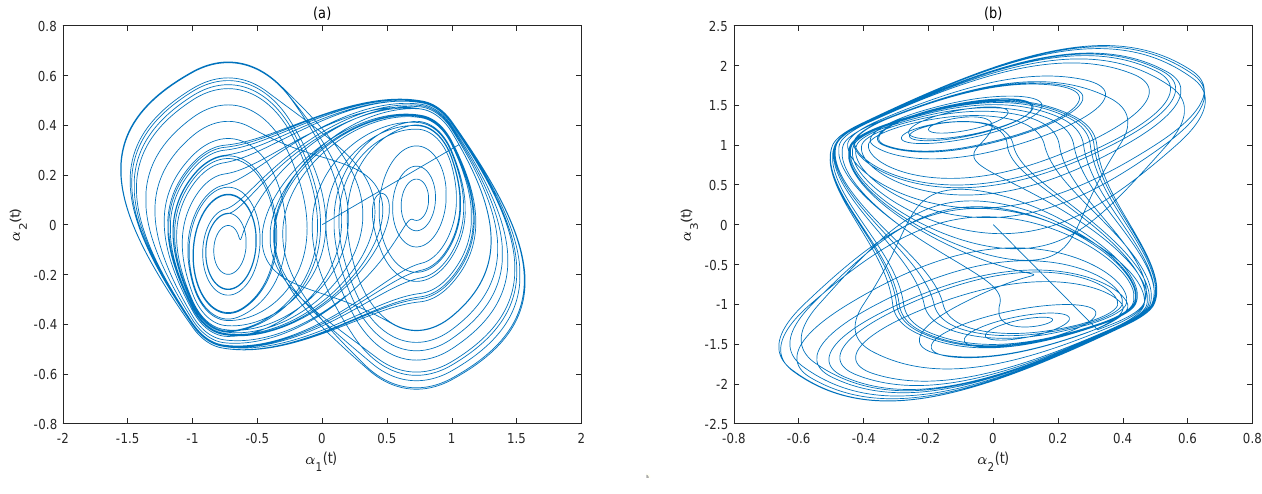
Figure 1. Chaotic behavior of α ( t ) on ( a ) α 1 − α 2 and ( b ) α 2 − α 3 . Table 1. Comparison of the σ min and Q 0 based on Corollary 2 (method in [22,35]) and Theorem